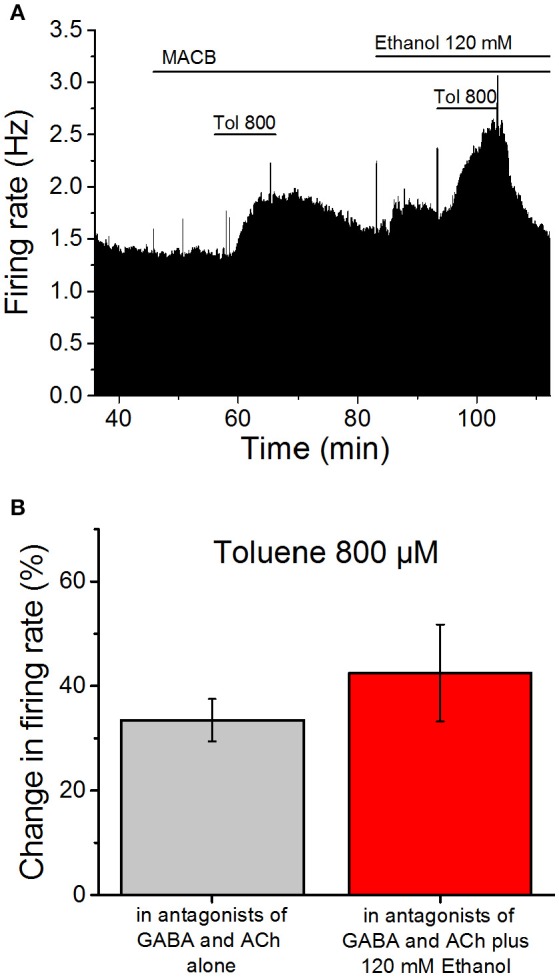
Ethanol does not occlude toluene-induced excitation. (A) Ratemeter diagram illustrating the results from a single VTA neuron undergoing the protocol used in the ethanol occlusion experiments. Vertical bars indicate the firing rate over 5 s intervals, and horizontal bars indicate the duration of drug administration (specific drugs indicated above these bars). After beginning a recording, the same antagonist cocktail described in the legend to Figure 2 was added to the superfusate. Toluene (800 μM) was tested and then washed out. Then ethanol (120 mM) was added to the superfusate and, after 10 min, the same concentration of toluene was tested again. In this recording, toluene increased the firing rate by 34.0% prior to ethanol and 39.5% in the presence of ethanol, while ethanol alone produced a 15.4% increase in firing rate. (B) Toluene (800 μM) was tested before (gray bar) and in the presence of 120 mM ethanol (red bar). Note that a cocktail of mecamylamine (1 μM), atropine (5 μM), bicuculline chloride (10 μM) and CGP35348 (10 μM) is present during the whole experiment. The effect of toluene was not altered significantly by the presence of ethanol (n = 8).